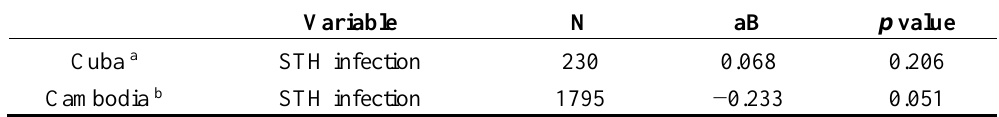
Table 4. Linear regression models of zinc by STH